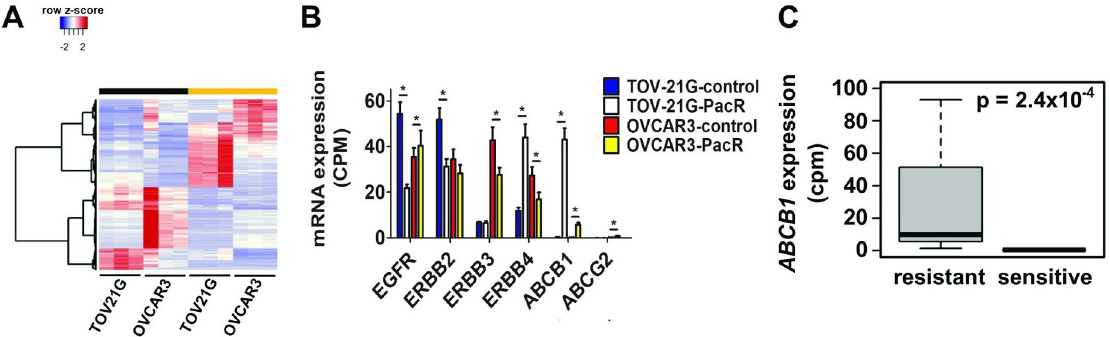
Fig 2. ABCB1 overexpression among recurrent gene expression differences tracking with paclitaxel resistance in ovarian cancer. (A) Supervised hierarchical clustering of 229 common transcripts phenotypically segregated 111 down-regulated and 118 up-regulated transcripts in PacR cells (orange bar) from control cells (black bar). (B) mRNA expression levels measured by RNAseq in control and PacR cells were compared within cell lines for EGFR , ERBB2 , ERBB3 , ERBB4 , ABCB1 and ABCG2 ( � q < 0.05). (C) ABCB1 mRNA expression levels measured by RNAseq compared in paclitaxel-sensitive and -resistant ovarian cancer organoids. Statistical significance determined by exact test ( edgeR ).